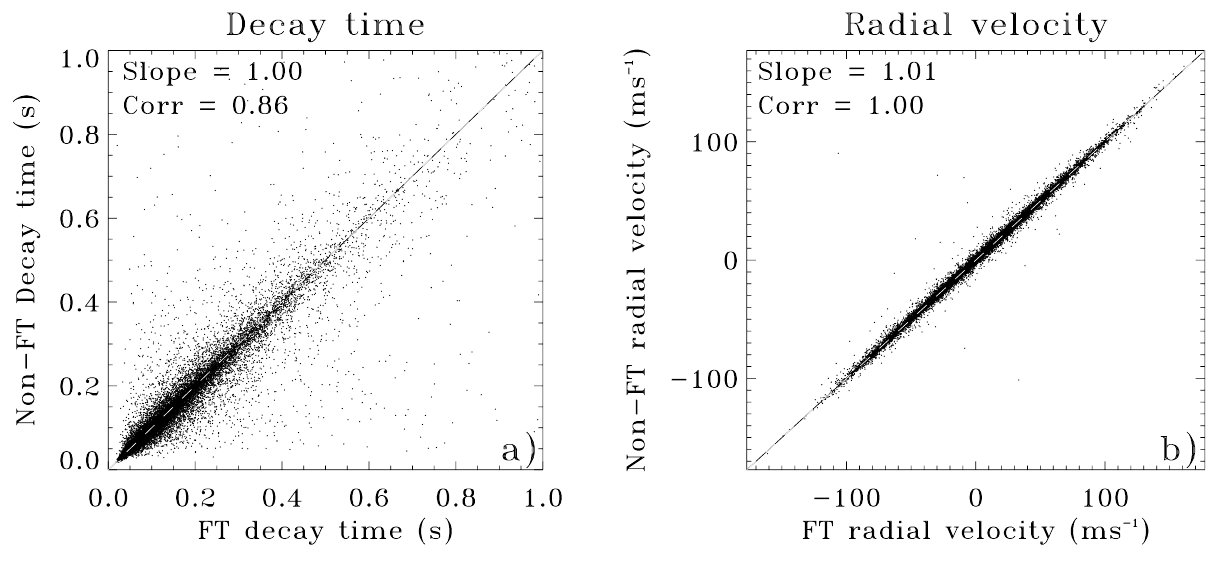
Fig. 8. Scatter plots of (a) decay times and (b) radial drift speeds obtained using meteor echoes (y-axis) and their Fresnel transform (x-axis). The correlation is shown at the top of each plot.